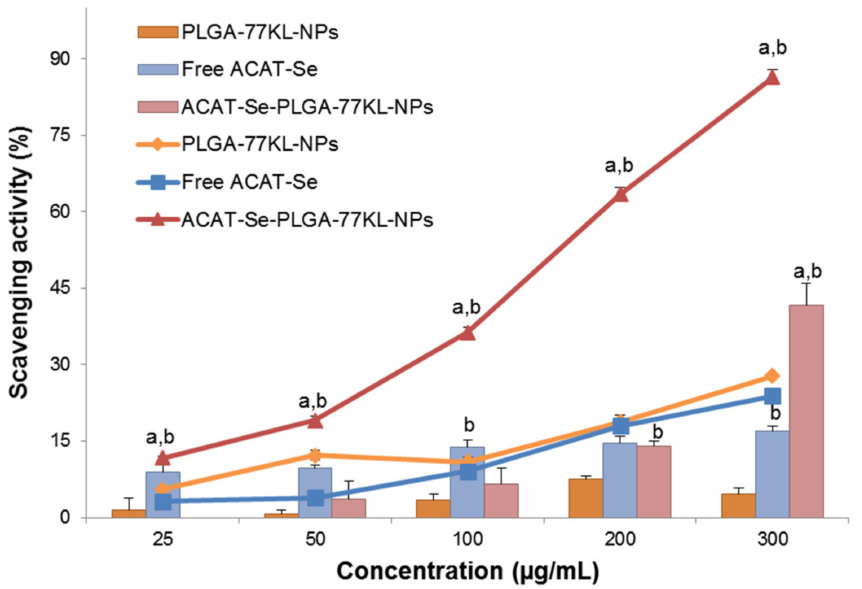
Figure 2. Scavenging activity of free ACAT-Se, PLGA-77KL-NPs and ACAT-Se-PLGA-77KL-NPs